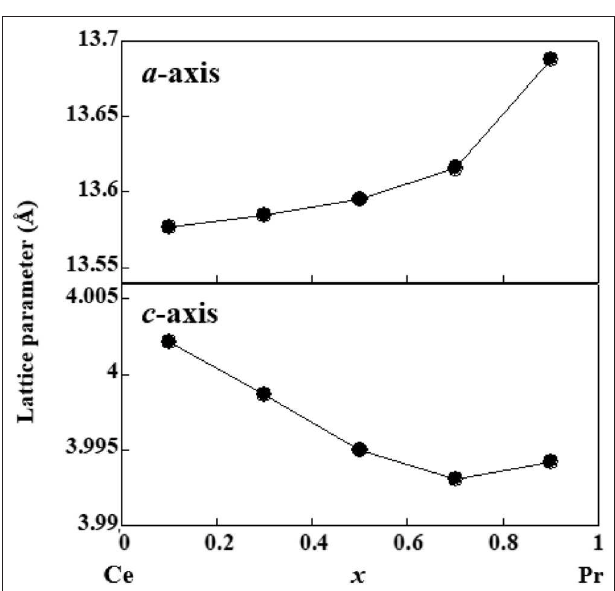
FIGURE 3 | Lattice parameters of a and c -axes of (Ce,Pr)OBiS 2 single crystals with 0.1 ≤ x ≤ 0.9 at 150K.